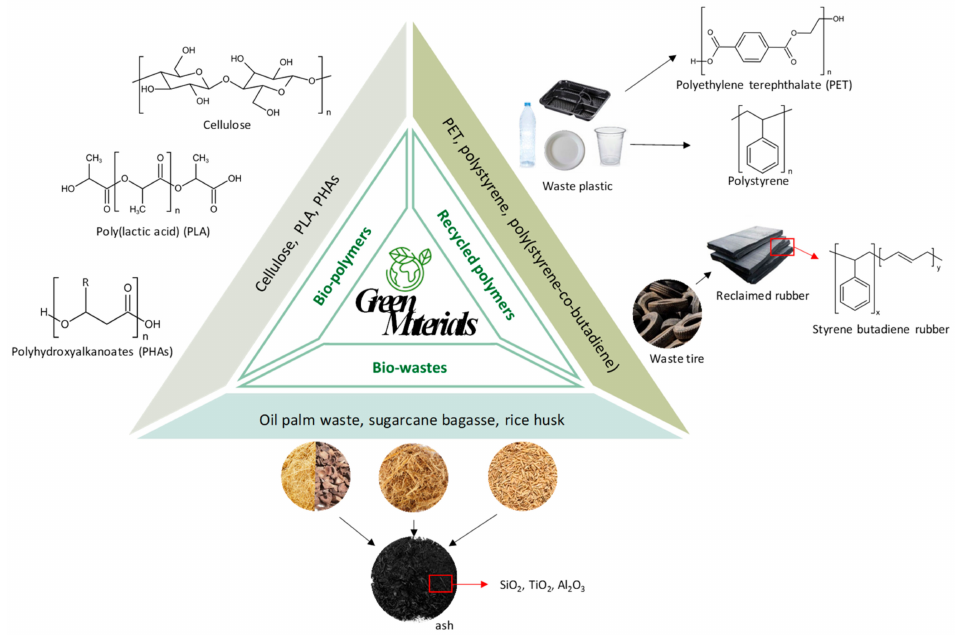
Figure 20. Sustainable materials used to fabricate green hollow fiber